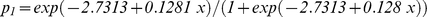
Model of the probability of occurrence of pneumonia.The probability of developing pneumonia is depicted using a proportional odds model. p1, the probability of severe pneumonia; p2, the probability of mild/moderate pneumonia; x, time until oseltamivir administration from symptom onset.

The solid line indicates the probability of occurrence of severe pneumonia (p1). The dotted line indicates the probability of occurrence of any severity of pneumonia (mild to severe pneumonia, p1+p2).